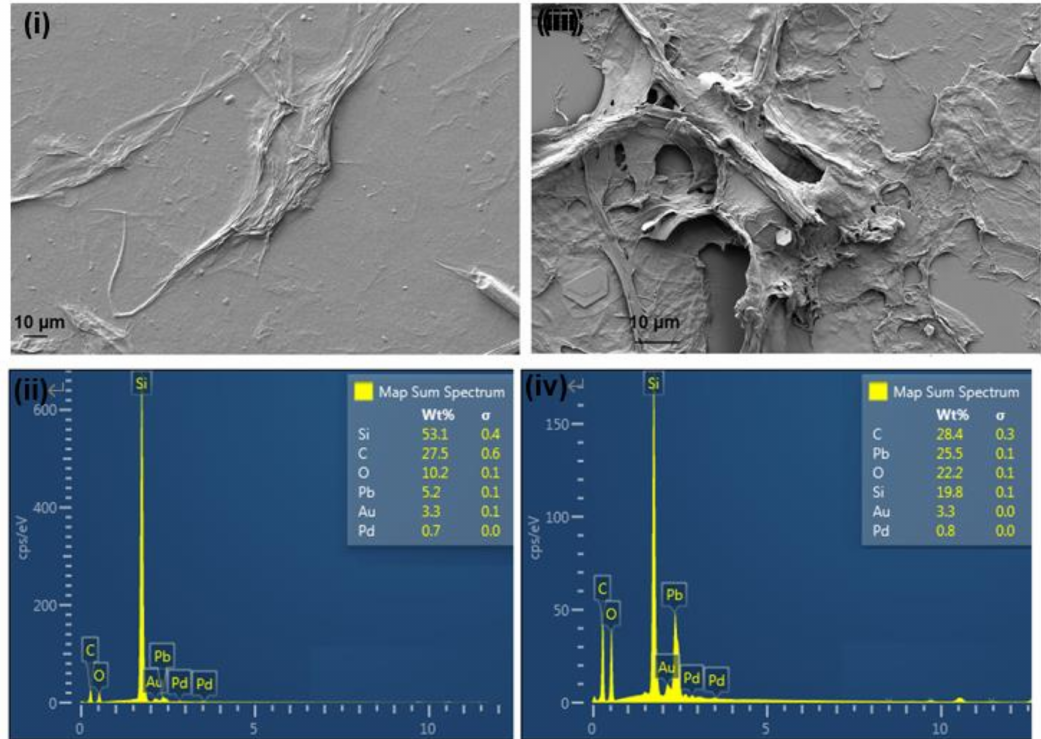
Figure 6. ( i , ii ) SEM images Pb 2+ (250 ppm)@6CC and its corresponding EDX; ( iii , iv ) SEM image of Pb 2+ (250 ppm) @TCC and its corresponding